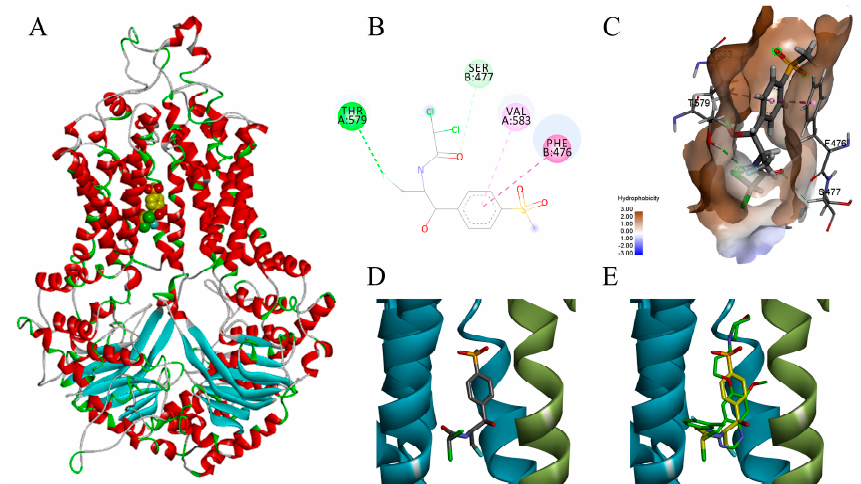
Figure 2. Molecular docking of florfenicol into the cBCRP target obtained using AutoDock Vina. ( A ) Homology model of the BCRP (ribbon representation colored according to secondary structure) and florfenicol (CPK(Corey–Pauling–Koltun) representation). ( B ) ligand interaction diagram of the florfenicol docking pose (dark green—conventional hydrogen bond; light green—carbon hydrogen bond; dark pink—pi-pi stacked interaction; light pink—pi-alkyl interaction; yellow—pi-sulfur interaction). ( C ) Florfenicol in the active sites delineated by the hydrophobic surface and surrounding residues which are labelled and represented as thin grey lines(dashed lines represent the same interactions as in B). Hydrogen atoms are not shown for clarity. ( D ) Florfenicol (thick grey lines) in the ligand binding domain of the cBCRP (ribbon representation: chain A colored in green and B in cyan). ( E ) Florfenicol (thick yellow lines) overlaid onto gefinitib (thick green lines) in the ligand binding domain of the cBCRP (ribbon representation: chain A colored in green and B in cyan).